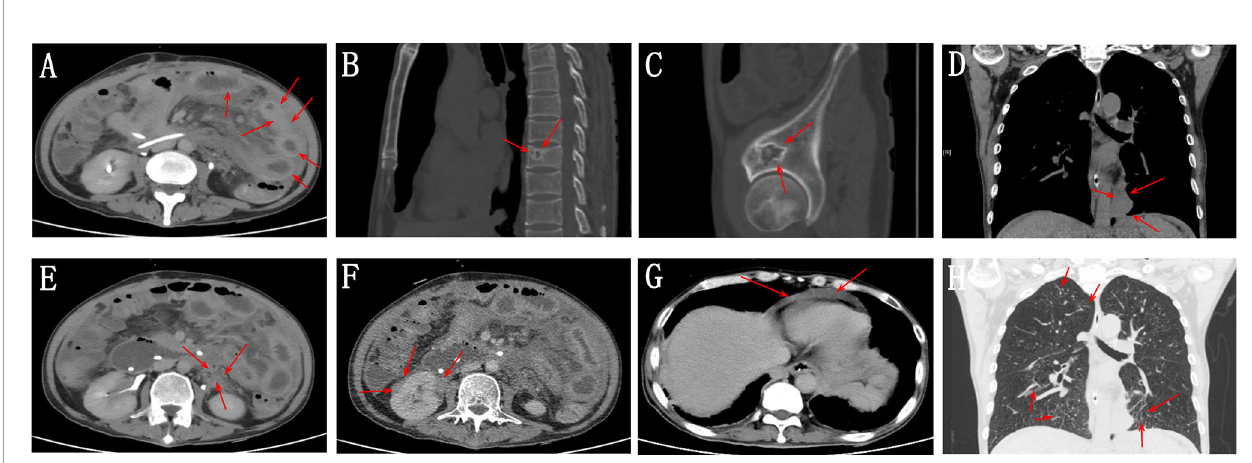
FIGURE 2 | (A) Abdominal CT scan showing mural thickening of the small bowel loops (red arrow). (B, C) Whole-body CT scan showing lytic lesions with sclerotic margins in the vertebral bodies and iliac bones (red arrow). (D) Chest CT scan showing soft tissue in left paravertebral location (red arrow). (E, F) Abdominal CT scan showing retroperitoneum and perinephric soft tissue density foci (red arrow). (G) Chest CT image showing pericardial effusion. (H) Chest CT image showing reticular opacities in both lungs.